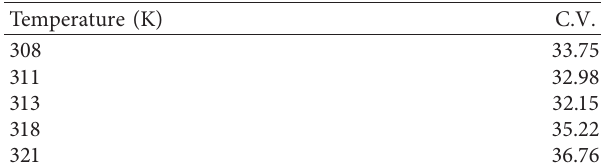
Table 4: C.V. of the product with different temperatures.